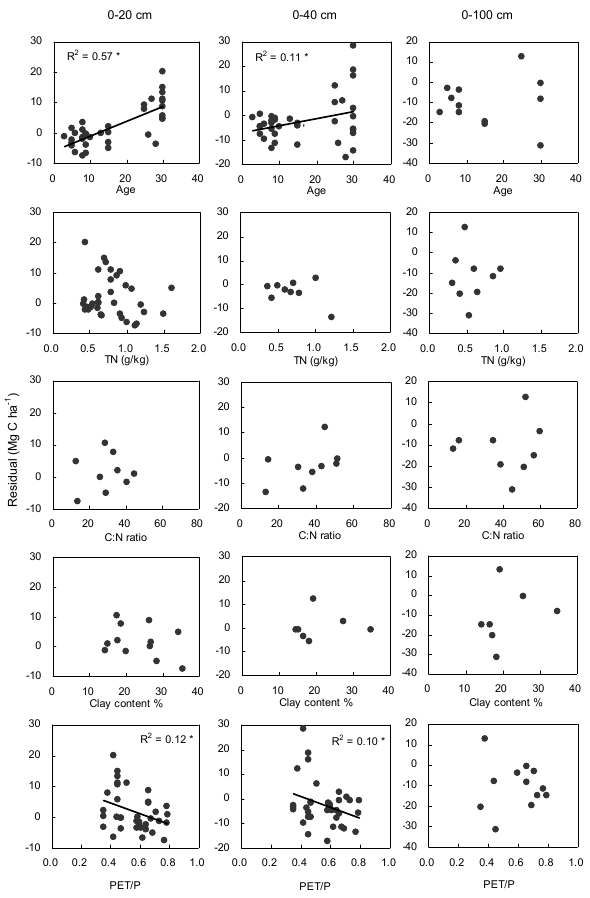
Fig. 10. Correlations of model residuals (modeled-measured mean) 30 with plantation age, soil TN, soil C:N ratio, clay content, and PET/ P in three soil depth ranges. Star indicates the correlation is significant ( p